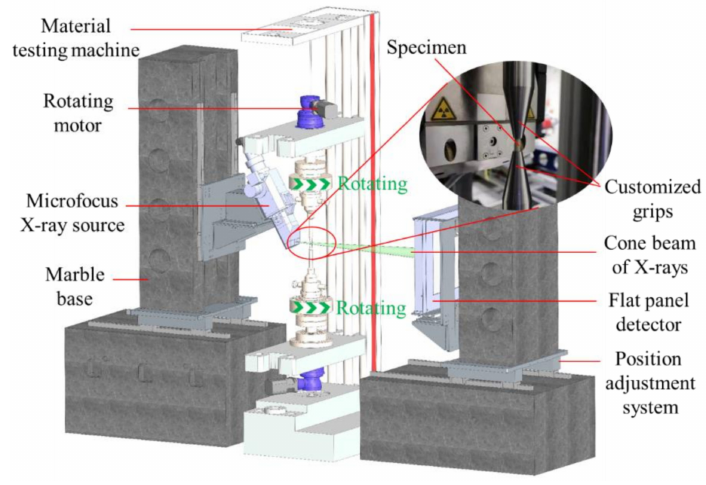
Figure 2. Schematic of the in situ X-ray computed tomography apparatus.